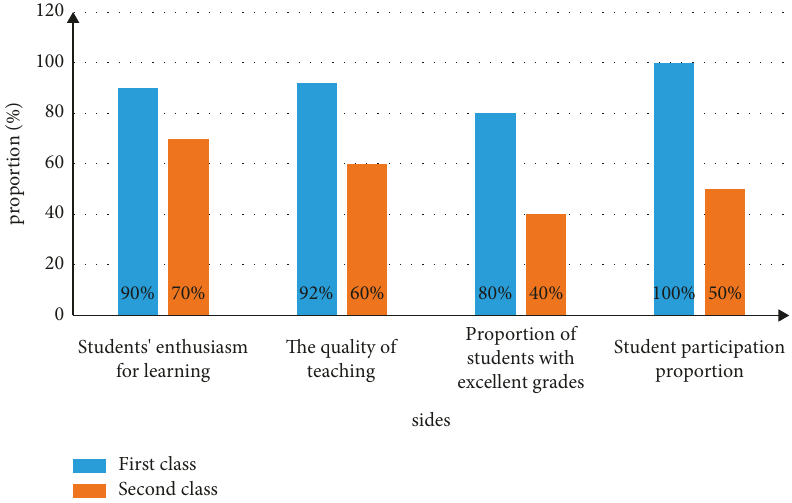
Figure 8: Comparison of all aspects of the two classes. Table 2: Learning status of smart cloud